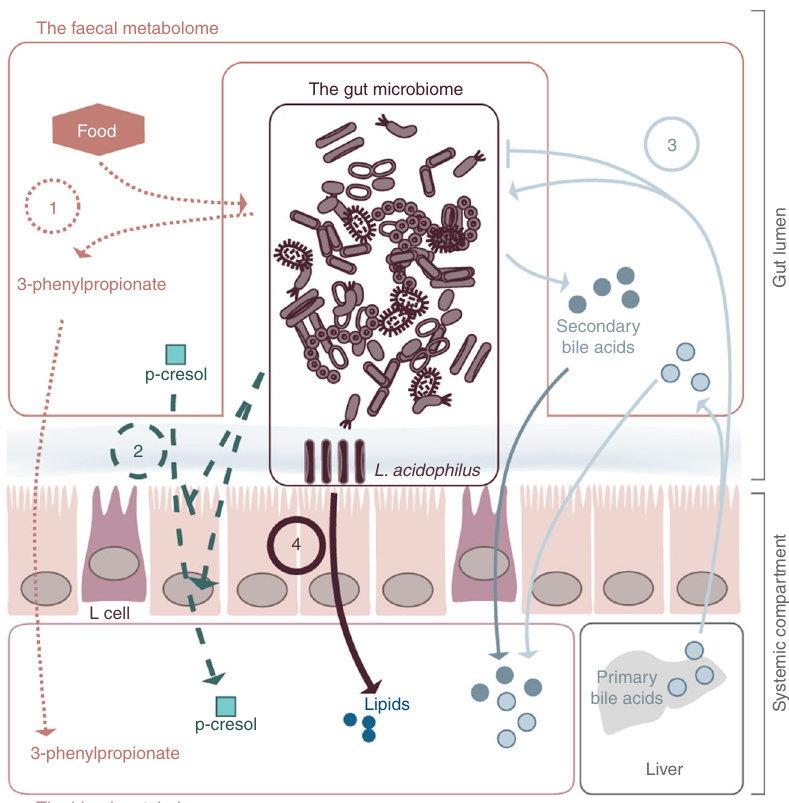
Fig. 3 Potential mechanisms implicated in the interplay between the gut microbiome, the faecal metabolome, and the blood metabolome. (1) Small dashed lines: metabolites are produced by the microbiota and then absorbed, resulting in associations between the microbiome and both the blood and faecal metabolites. (2) Large dashed lines: the microbiome affects the gut barrier integrity, resulting in alterations of metabolites absorption (i.e., the same metabolite is associated with a species/pathway in both blood and faeces, but the directions of effects are opposite). (3) Light continuous line: metabolites produced by the host, such as bile acids, affect microbial growth. (4) Bold continuous line: direct microbiome to host cell interactions that result in host systemic modulation (i.e., species are associated with blood metabolites but not with faecal